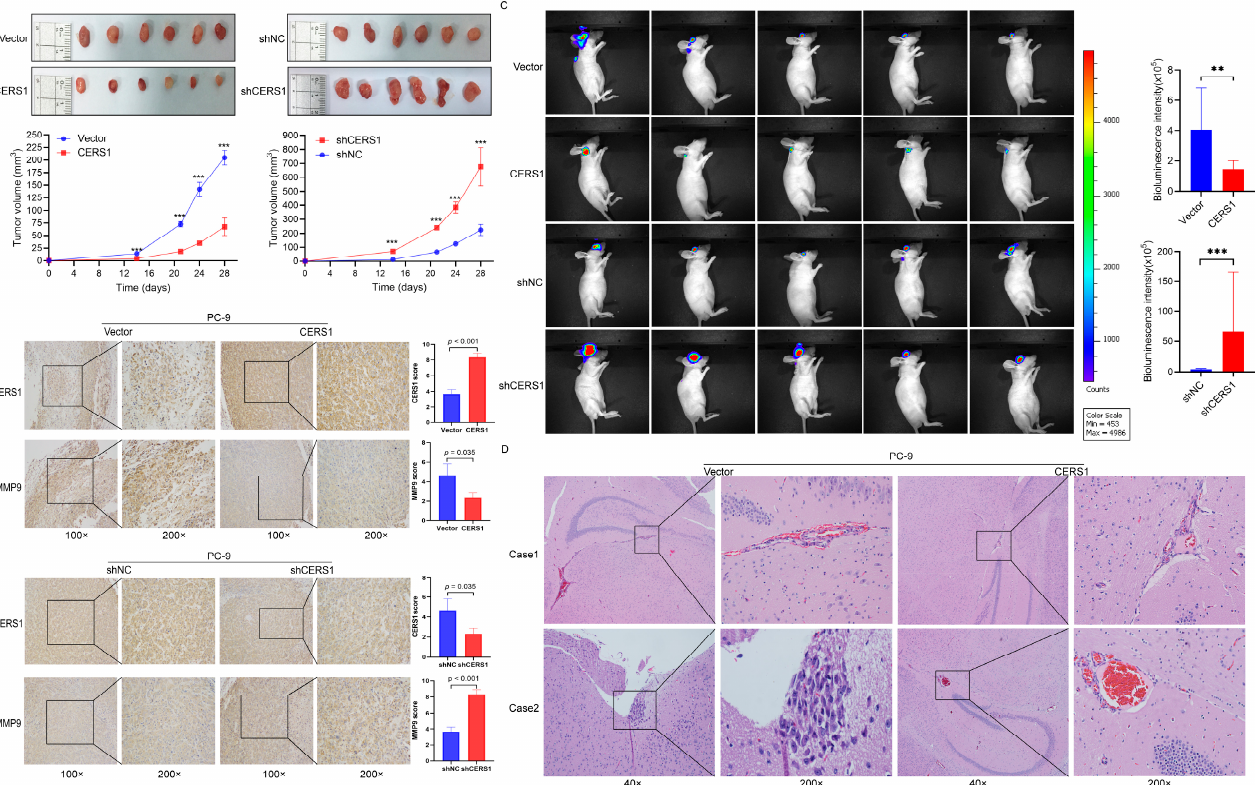
Figure 5. CERS1 suppresses tumorigenesis and brain metastasis in vivo. ( A ) PC-9 cells with stable knockdown and overexpression of CERS1 were used to establish a subcutaneous xenograft model, and the tumor growth curves were plotted. ( B ) Expression of CERS1 and MMP9 in subcutaneously transplanted tumors was detected through immunohistochemical staining. ( C ) Bioluminescent images of mice injected with CERS1-overexpressing cells in the orthotopic xenograft model. ( D ) Hematoxylin and eosin-stained images (40× and 200×) of mice with brain metastases. ** p < 0.01; *** p < 0.001.